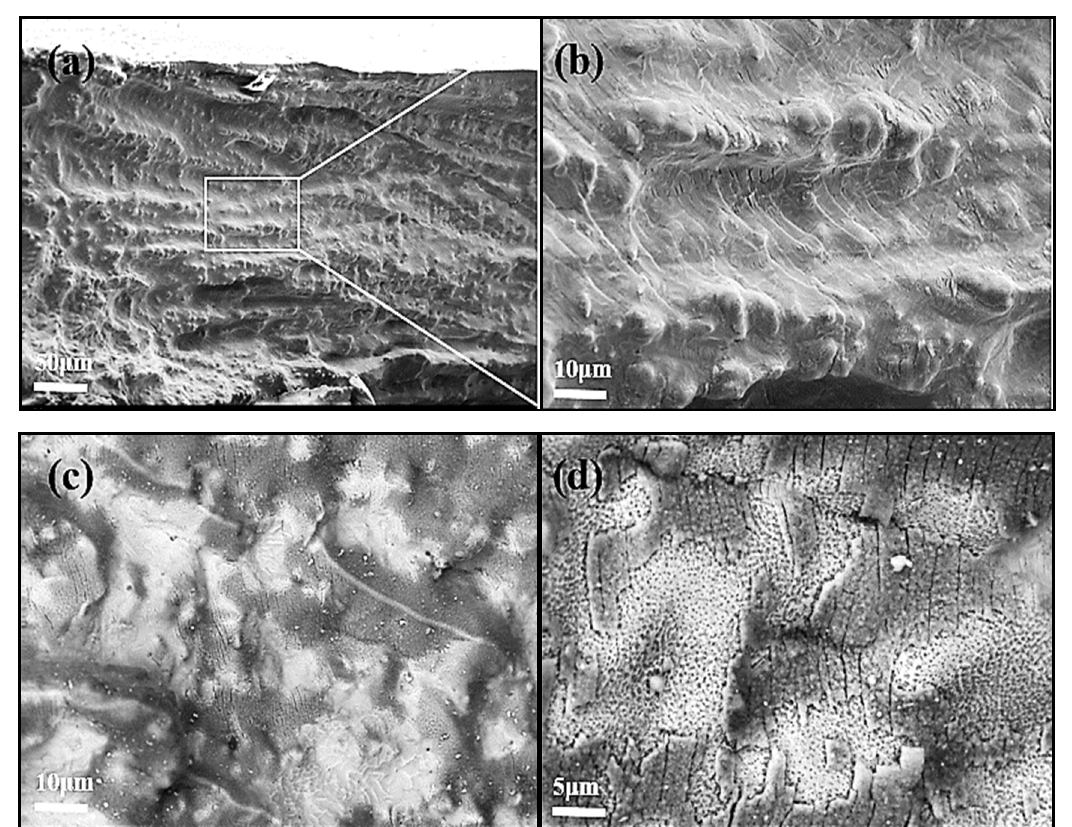
Figure 5. Fracture morphology of SFC of nickel-based alloy: ( a ) all-sided fracture surface; ( b ) selected zoom of ( a ); ( c ) liquefaction case 1; and ( d ) liquefaction case 2.